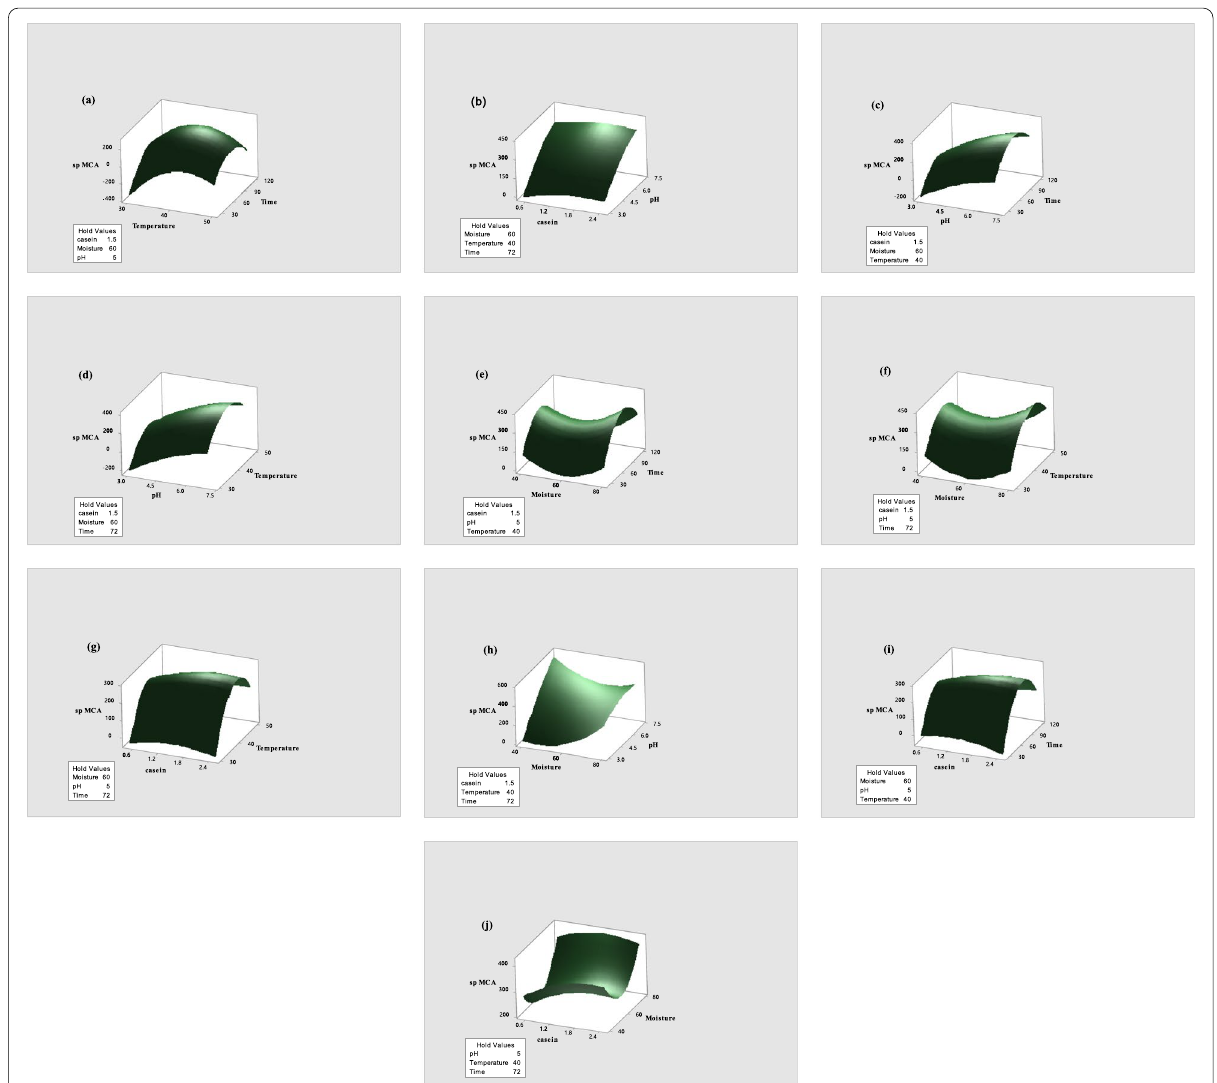
Fig. 2 3D Response surface plots representing the interaction between each two independent variables and their effect on spMCA. Other variables were kept at their constant level. a spMCA vs temperature; time, b spMCA vs casein; pH, c spMCA vs pH; time, d spMCA vs pH; temperature, e spMCA vs moisture; time, f spMCA vs moisture; temperature, g spMCA vs casein; temperature, h spMCA vs Moisture; pH, i spMCA vs casein; time, j spMCA vs casein;